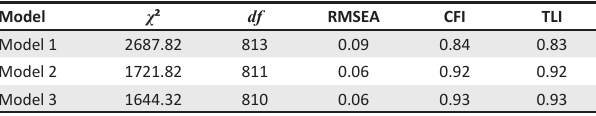
TABLE 2: Fit statistics for the competing measurement models.